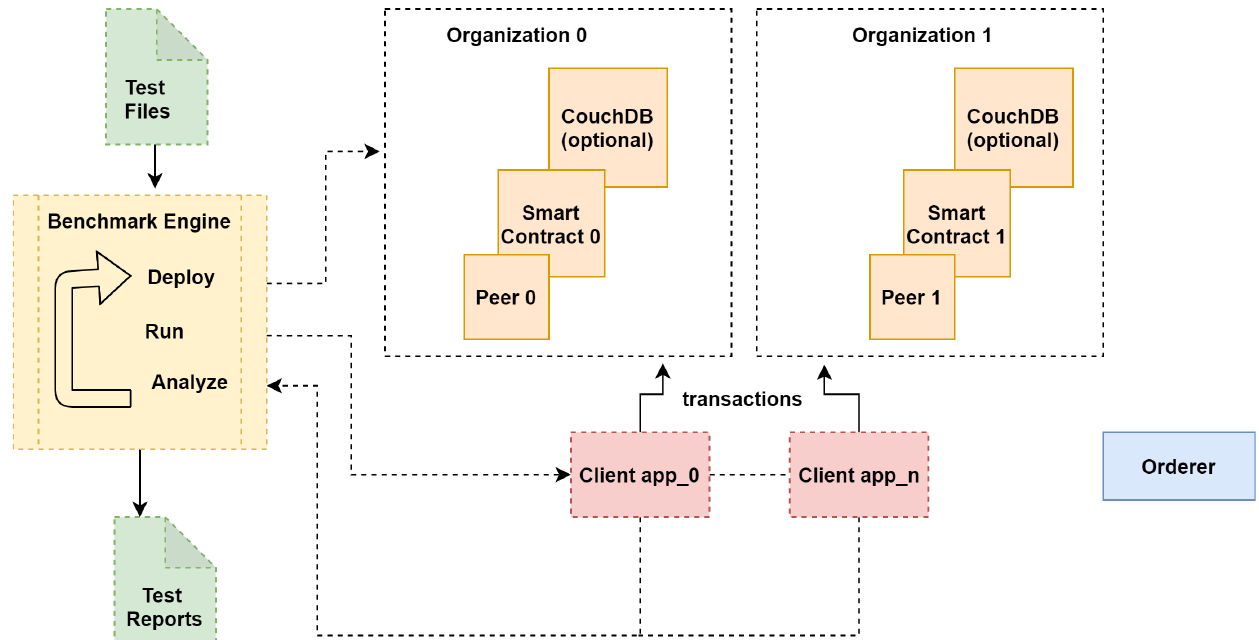
Figure 14. Blockchain test framework.